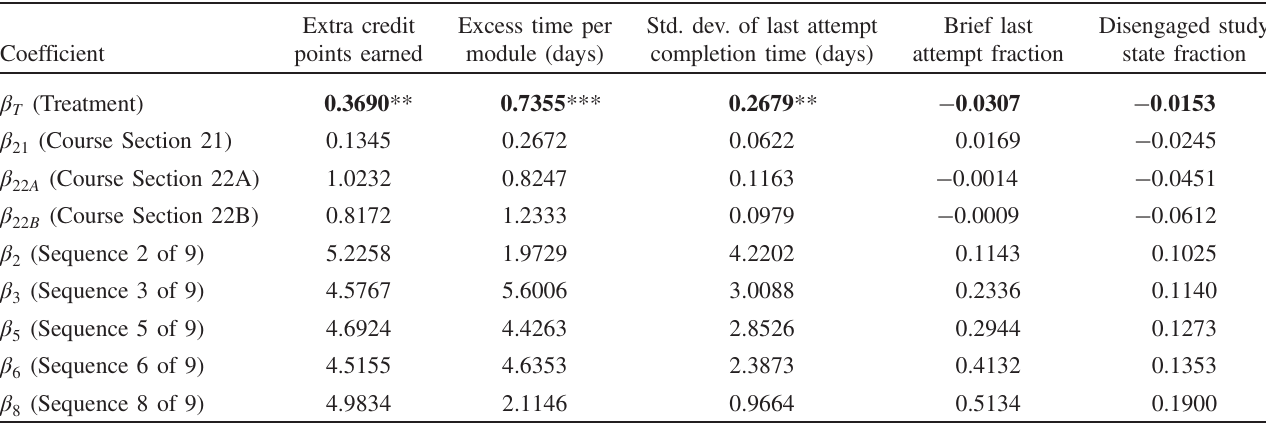
2. Observed and modeled engagement metrics. Blue lines indicate observed averages, with error bars for 1 standard error of the mean. Orange dotted lines show the modeled values from Eq. (1). Purple crosses show the model ’ s prediction of each metric if the planning-prompt intervention had not been implemented ( β T T ≡ 0 ). The gap between the orange dotted line and the purple cross thus indicates the estimated effect size. The purple marks appear only for sequences that received the intervention, which sequence this is differs by class TABLE I. Model coefficients for various procrastination metrics. The coefficients listed correspond to those in Eq. (1); p values for treatment coefficients come from significance tests for differences from 0. The test used is a t test with modification to make it robust against heteroskedasticity (unequal variances).